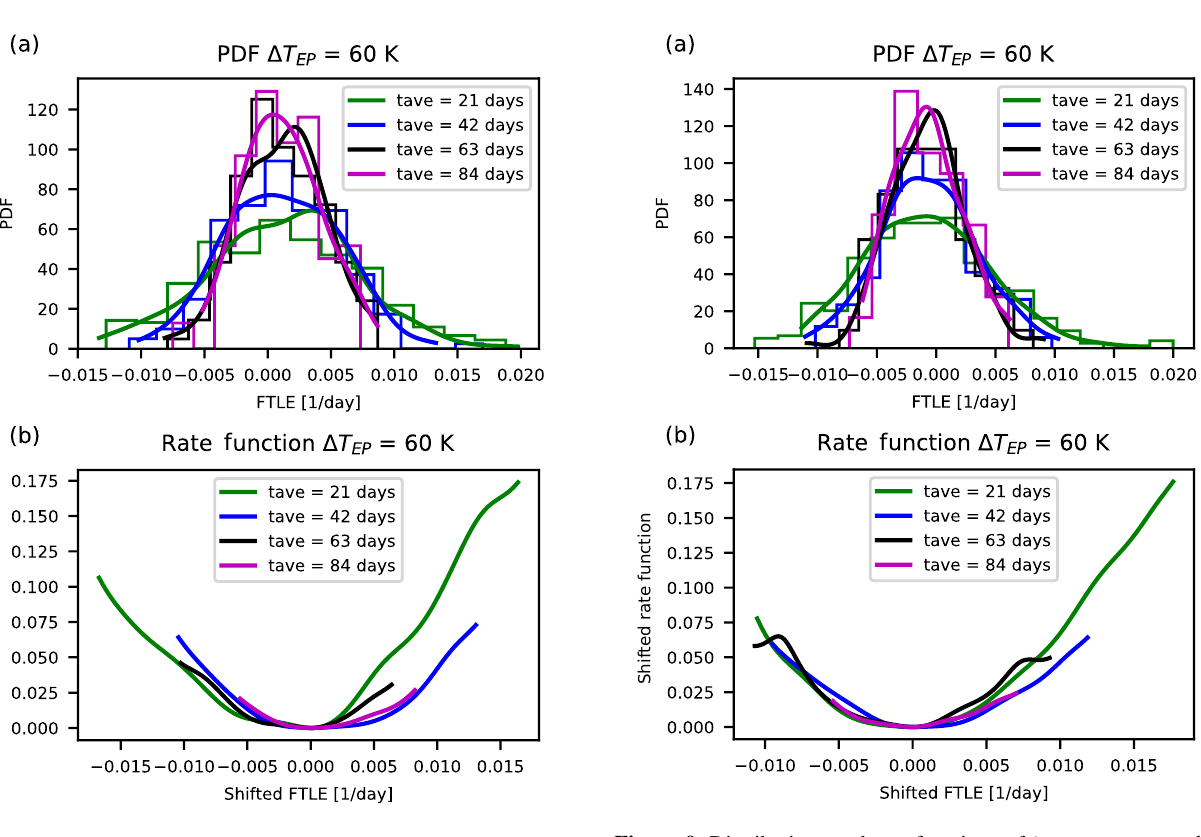
Figure 8. Distributions and rate functions of λ 66 , a near-zero, grow- ing instability in PUMA, for (cid:49)T EP = 60K. Panels as in Fig. 2.